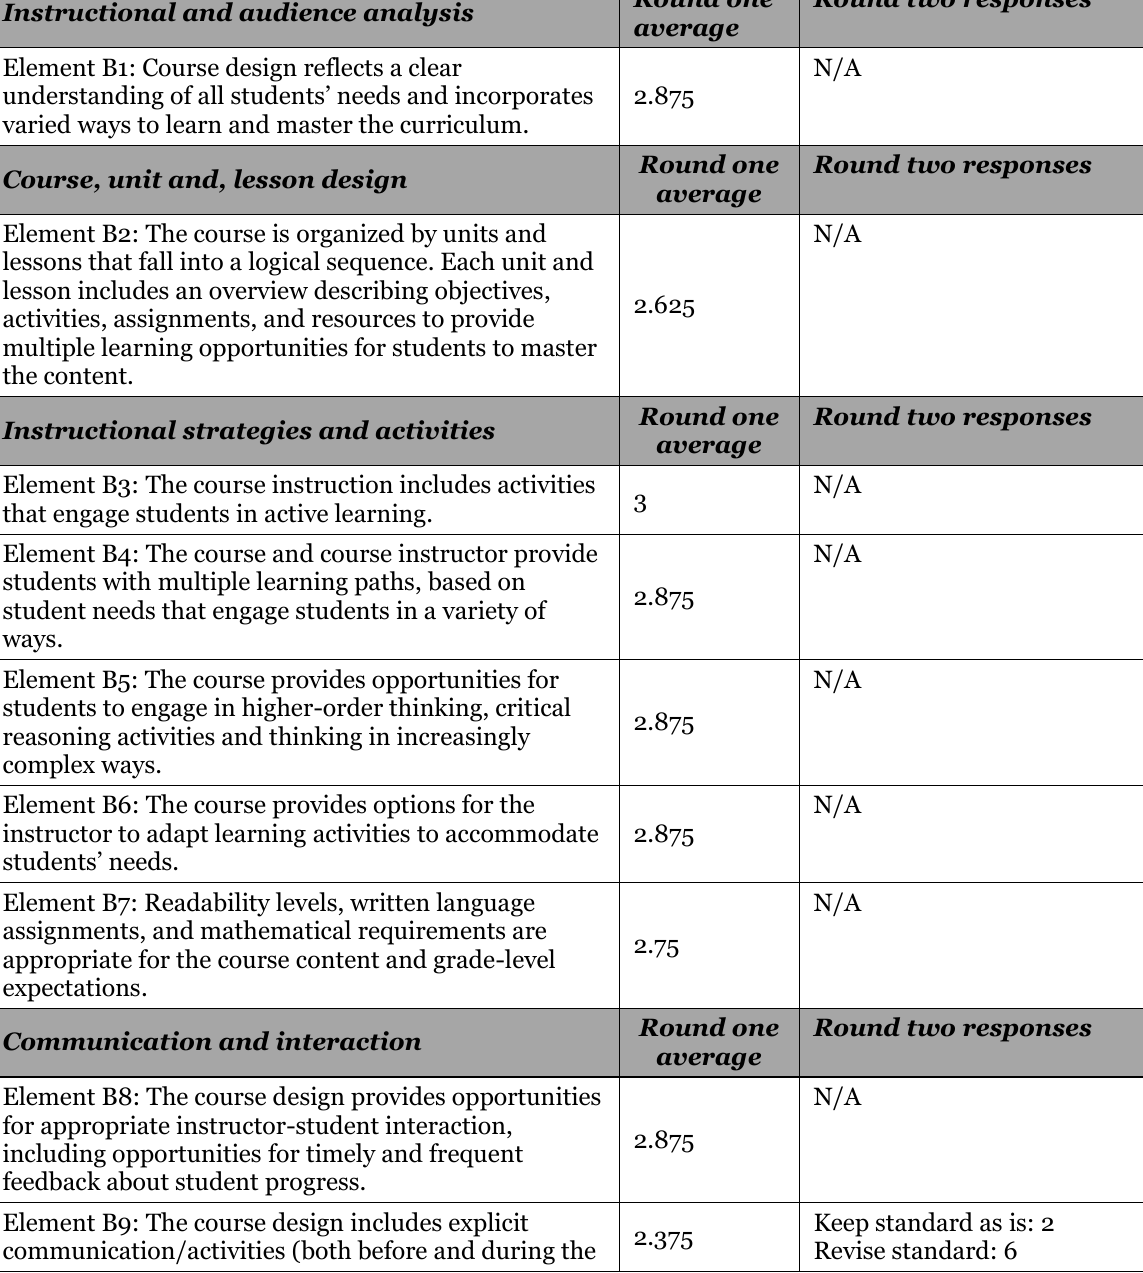
Instructional and audience